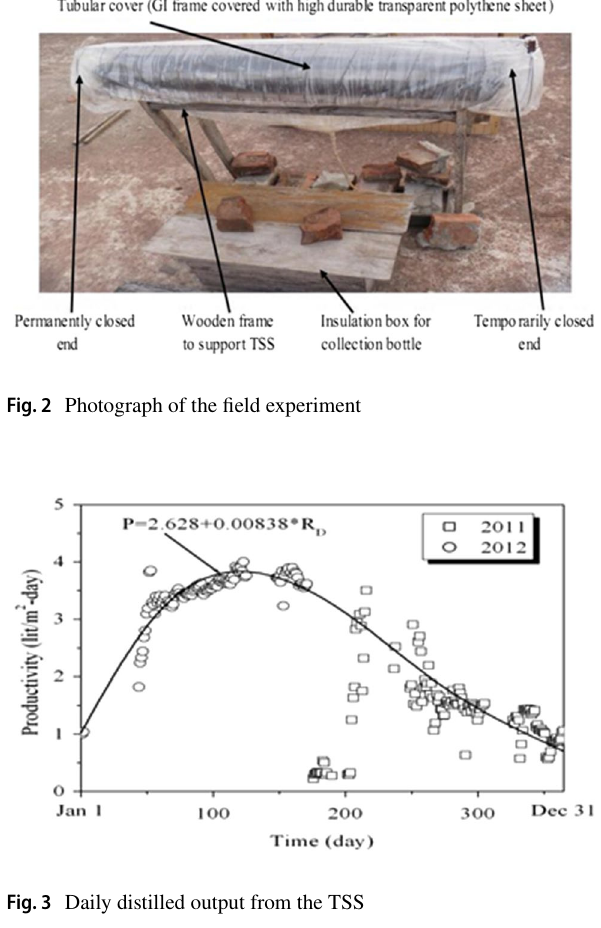
Fig. 3 Daily distilled output from the TSS